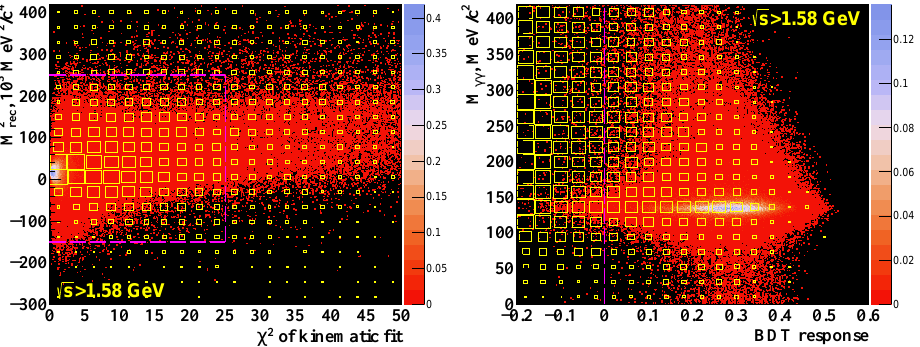
Figure 2. Squared recoil mass M 2 Figure 3. Reconstructed photon pair invariant vs χ 2 of kine- rec matic reconstruction for the simulation (scatter- mass M γγ vs BDT response for the simulation plot) and the experimental data (box diagram). The (scatter-plot) and the experimental data (box dia- dashed lines correspond to applied criterion. gram). The dashed line designates cut